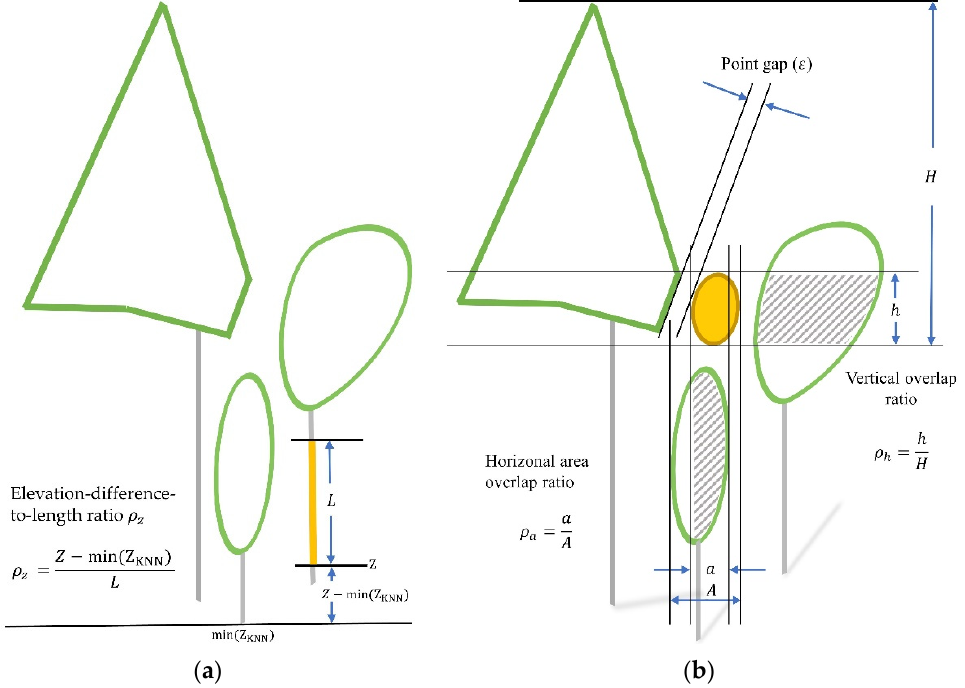
Figure 5. Geometrical illustration of calculating elevation-difference-to-length ratio ( a ) and the nearest measure between segments ( b ).